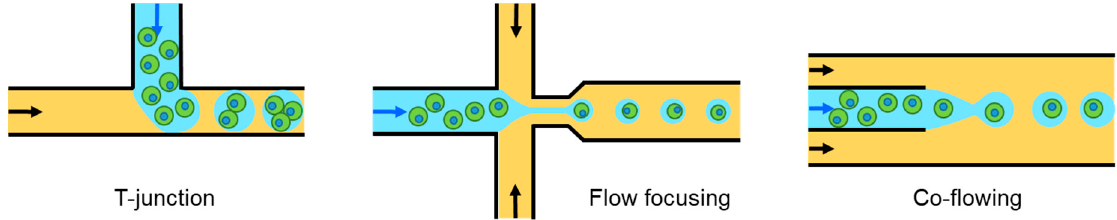
Figure 4. Microfluidic-based microdroplet generation by T-junction, flow focusing, and co-flowing